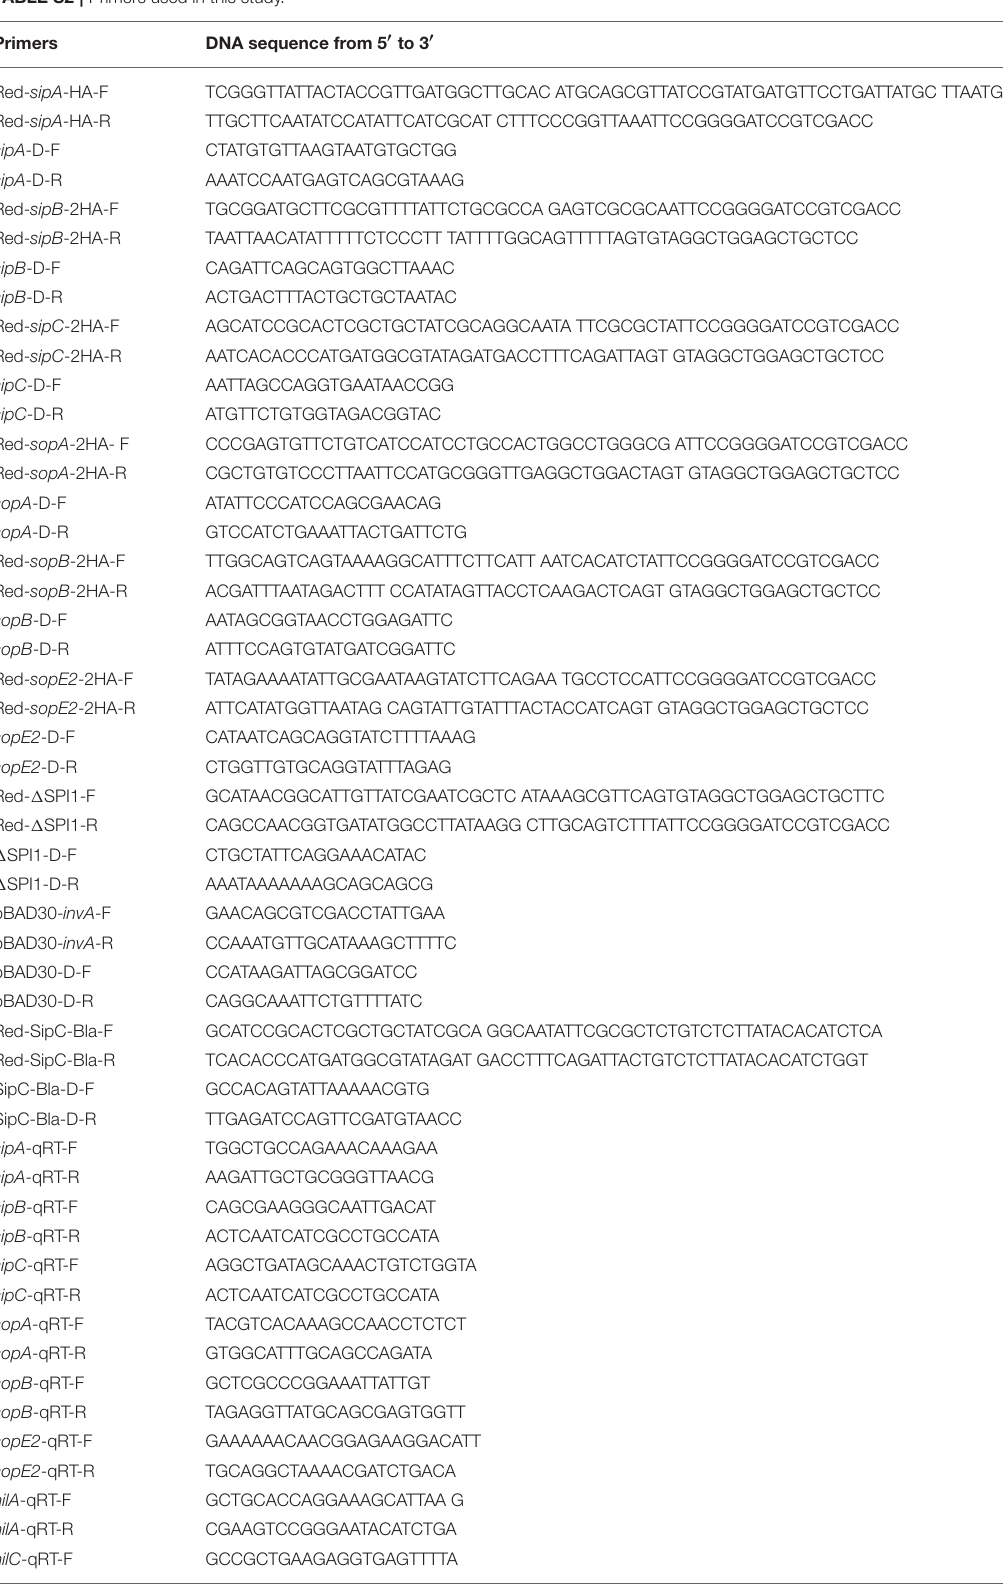
TABLE S2 | Primers used in this study. Primers DNA sequence from 5 ′ to 3 ′ Red- sipA